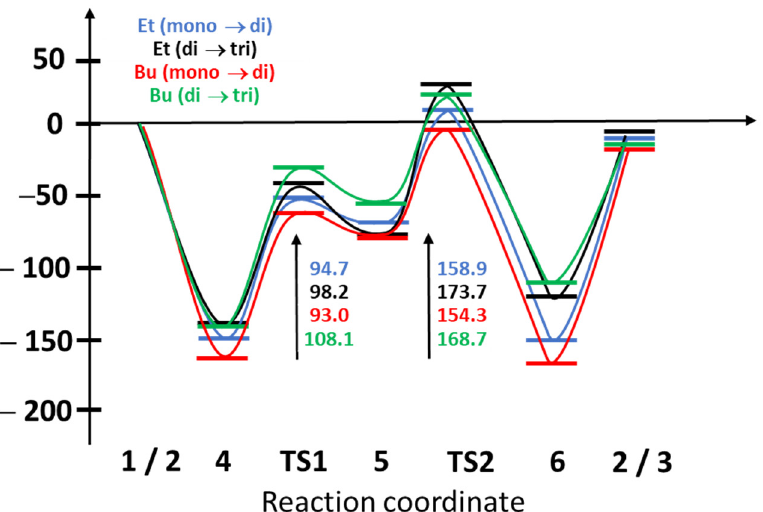
Figure 1. Enthalpy diagram for the monoalkylphosphate → dialkylphosphate → trialkylphosphate transformations obtained by DFT computations at the M062X/6–311+G (d,p) level of theory consid- ering the solvent effect of the corresponding alcohol.